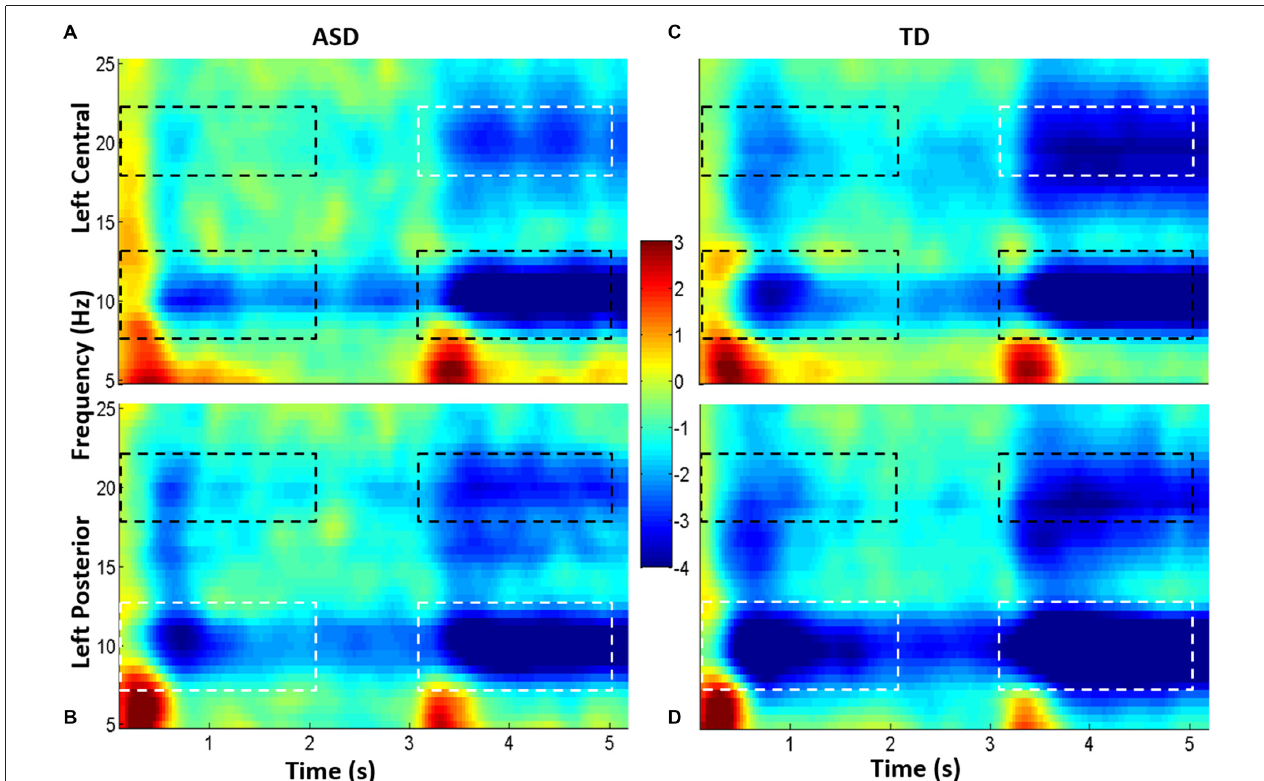
FIGURE 3 | Grand average spectrograms from children with high-functioning ASD (HFA; A,B) and typically developing (TD) controls (C,D). Cool colors represent event-related desynchronization (ERD), and warm colors represent event-related synchronization (ERS). ERD is indicated in unitless z -scores. Time is indicated along the x -axis (in seconds), and frequency is indicated along the y- axis (in Hz). The top spectrograms (A,C) represents the left central ROI, and the bottom, the left parietal ROI (B,D) . Dotted boxes indicate time-frequency regions that were averaged and compared between groups; regions that were statistically significantly different between groups are in white boxes; those which were not different are in black